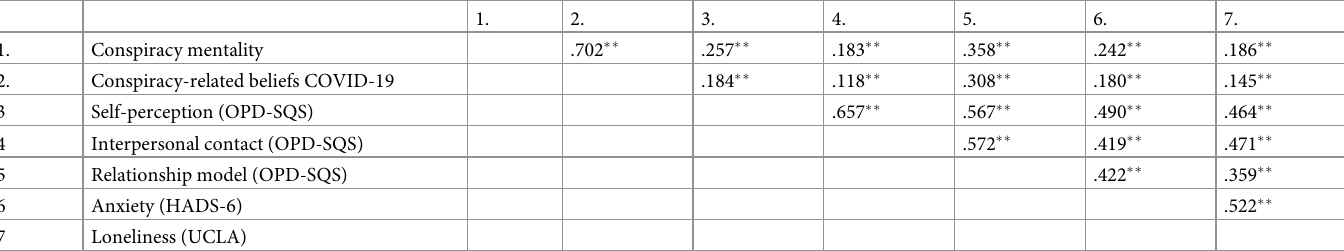
Table 2. Correlations of conspiracy mentality and conspiracy-related beliefs toward the COVID-19 pandemic with personality functioning and psychological state variables.